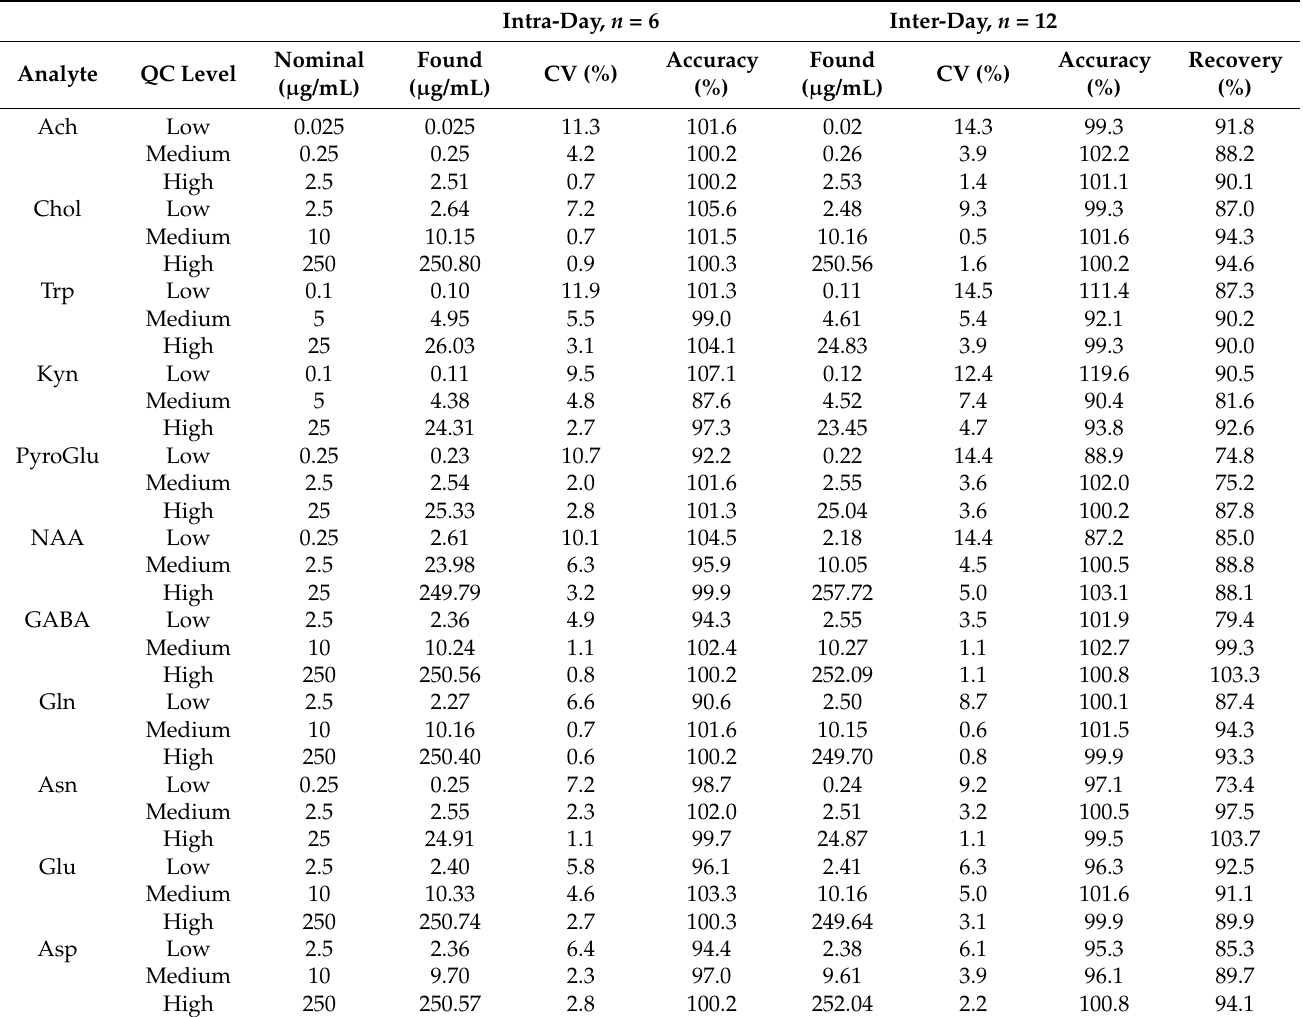
Table 3. Accuracy, precision and recovery of the UHPLC-MS/MS method for analysis of selected NT, tryptophan and